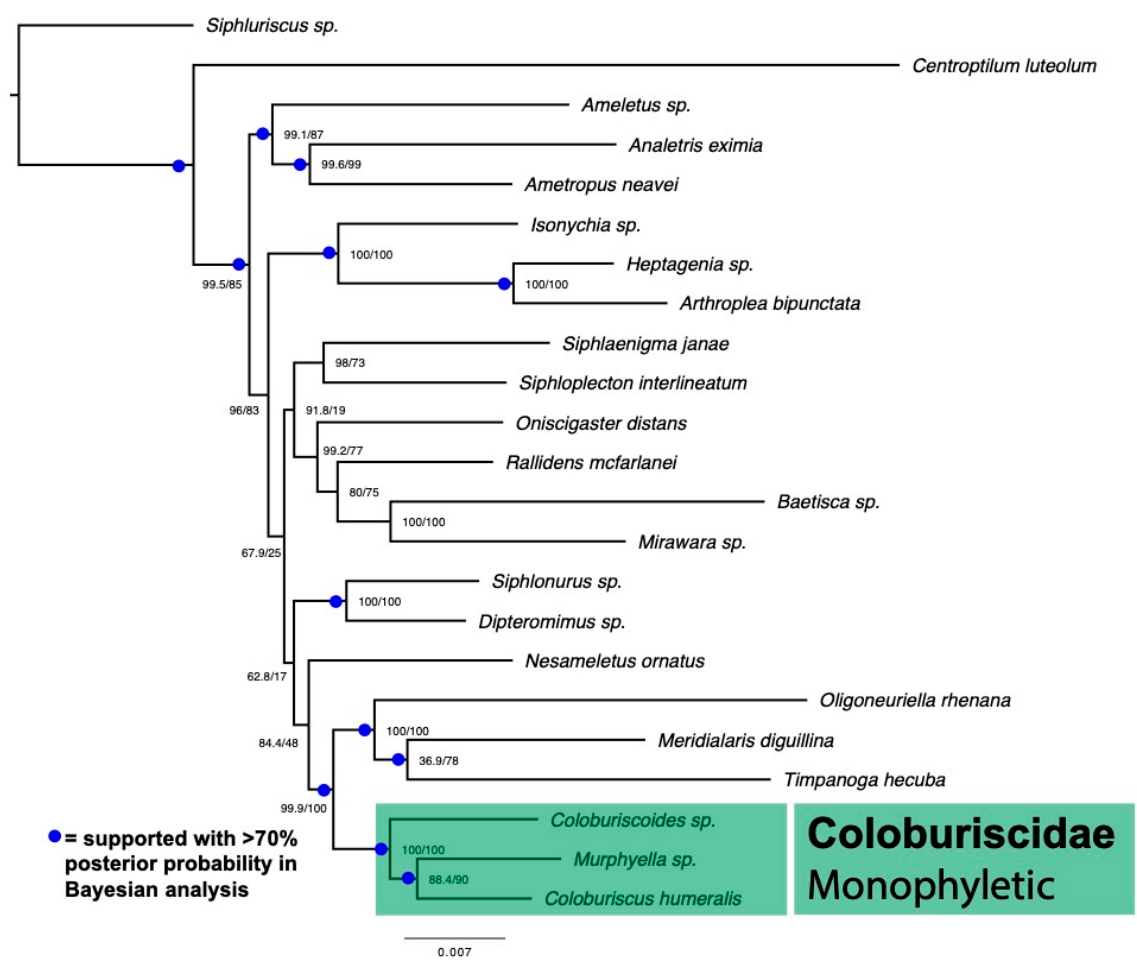
Figure 3. Maximum likelihood analysis of the phylogenomic DNA12 dataset. Results strongly support the monophyly of Coloburiscidae, highlighted in green. The blue circles indicate the nodes that were supported with >70% posterior probability in the Bayesian analysis. The numbers on the nodes are SH-aLRT support %/ultrafast bootstrap support %.